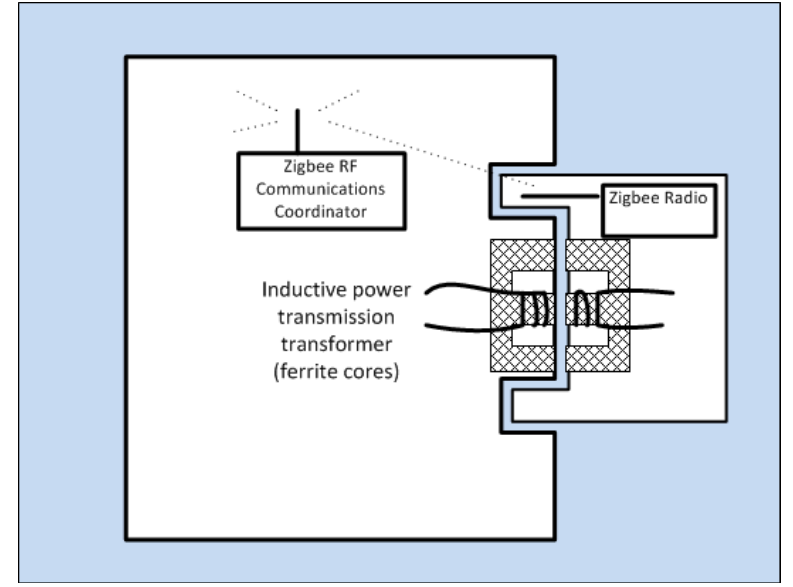
Figure 25. Test setup for underwater wireless